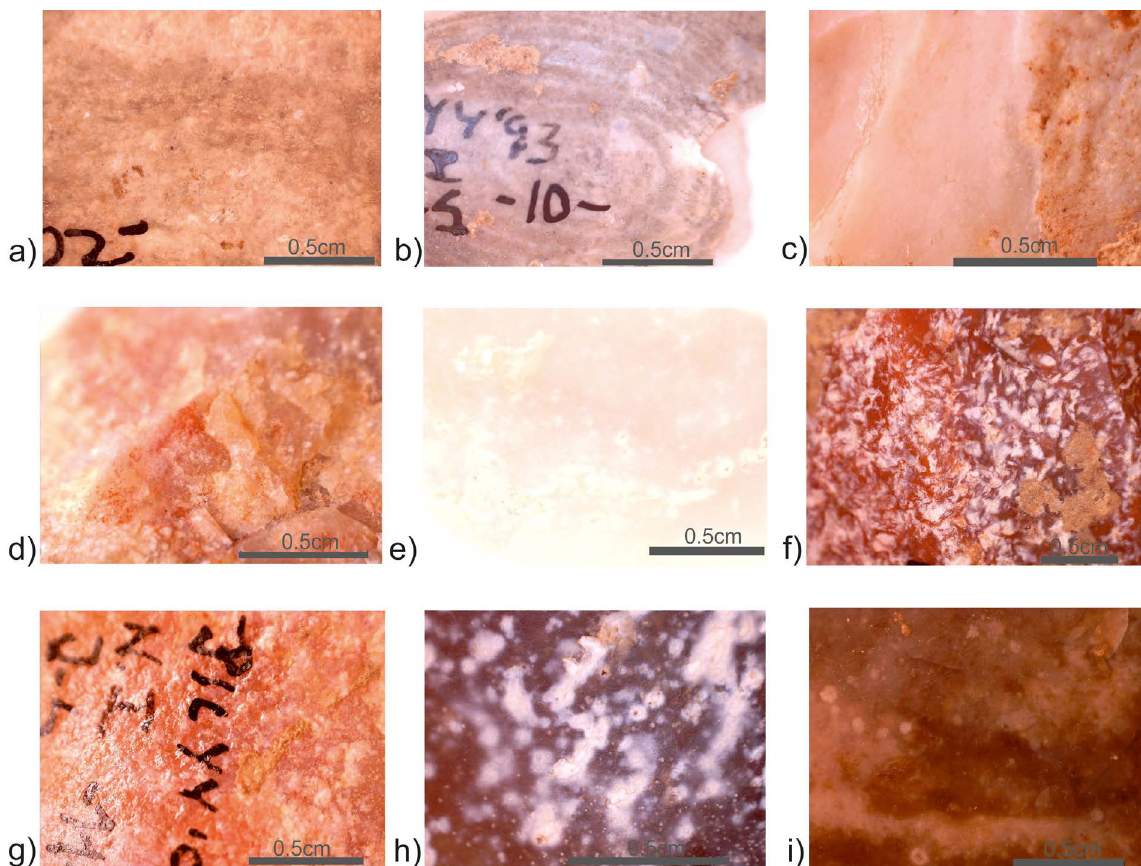
Figure 5. Macroscopic aspect of the chert varieties identified in the CIIA layer from the Picamoixons site: a) Vilaplana 1; b) Vilaplana 2; c) Morera 1; d) Morera 2; e) Maset 2; f) Maset 3; g) Vilella 1; h) Tossa 1; i) Tossa